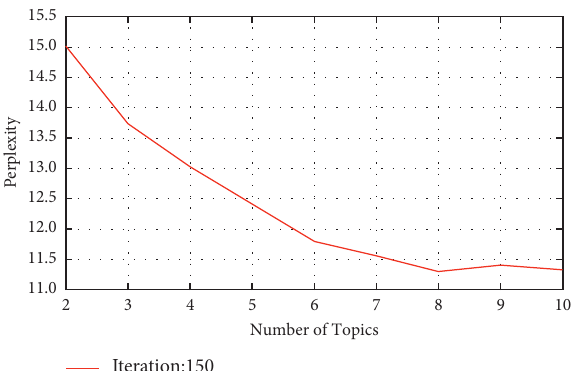
Figure 4: Determining an optimum function category based on the perplexity